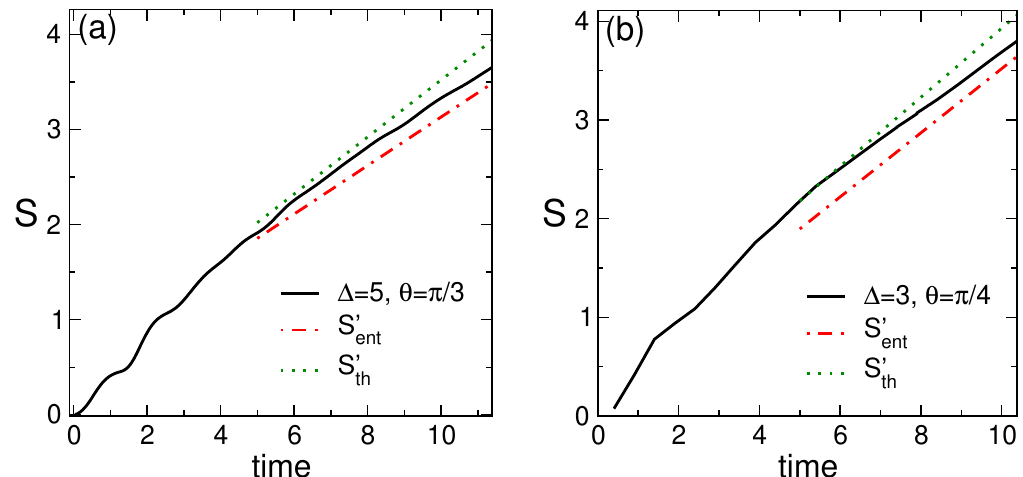
Figure 8: Entanglement dynamics after a bipartite quench in the XXZ chain. The initial state is obtained by joining the Néel state | N,0 〉 and the tilted Néel state | N, θ 〉 (24). The two panels report the dynamics for different values of the chain anisotropy ∆ and the tilting angle θ . The continuous lines are tDMRG results. The slope of the dashed-dotted line is S (cid:48) , the entanglement production rate at ζ = 0 ( cf . (88)). The ent slope of the dotted lines is S (cid:48) , the exchange rate of thermodynamic entropy at ζ = 0 th ( cf .